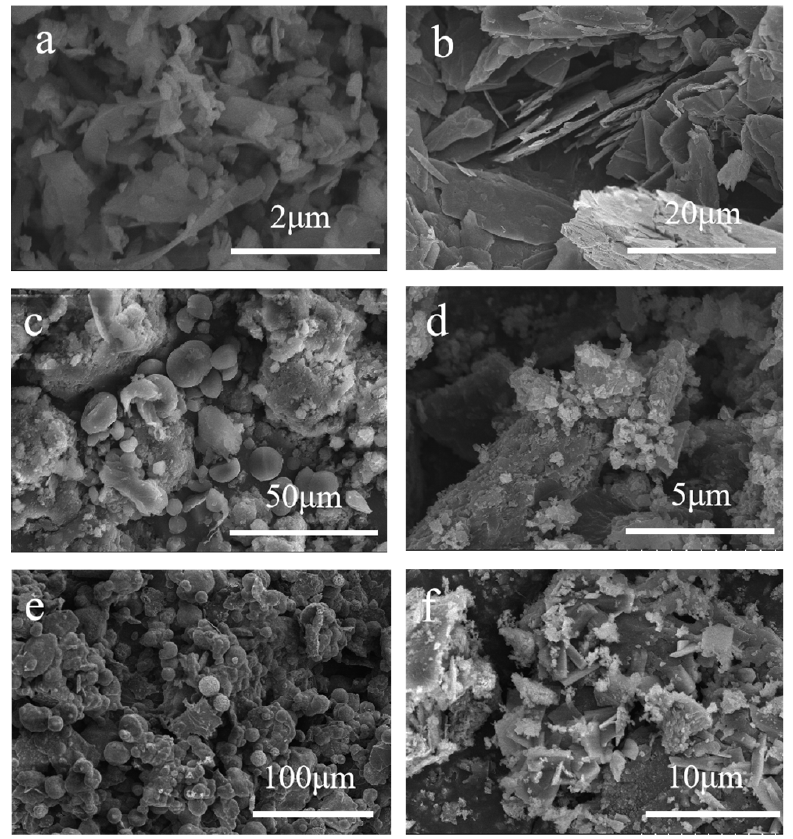
Figure 3. SEM images of ( a ) Si, ( b ) Graphite, ( c ) Si/C composite precursor, ( d ) Si/C, ( e ) Si/G/C composite precursor and ( f ) Si/G/C materials.